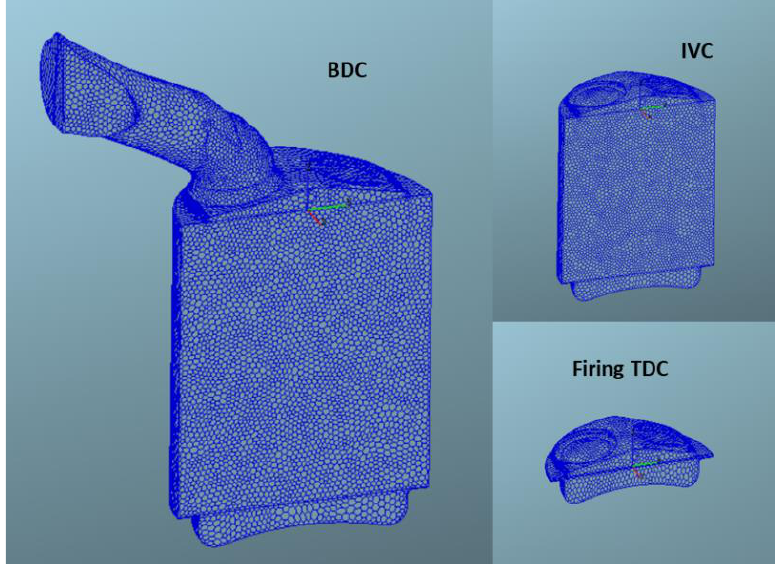
Figure 3. Three-dimensional engine mesh.